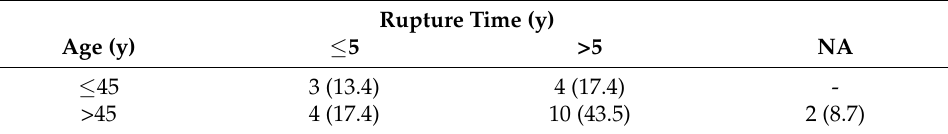
Table 4. Subjects above and below 45 years of age were identified, and the time of aneurysm or pseudoaneurysm breakup (before or after 5 years) was determined. The percentage was calculated on the total number of male individuals [23]. In two cases, which are not counted in the table, the time to the breakup was not defined (NA)0.